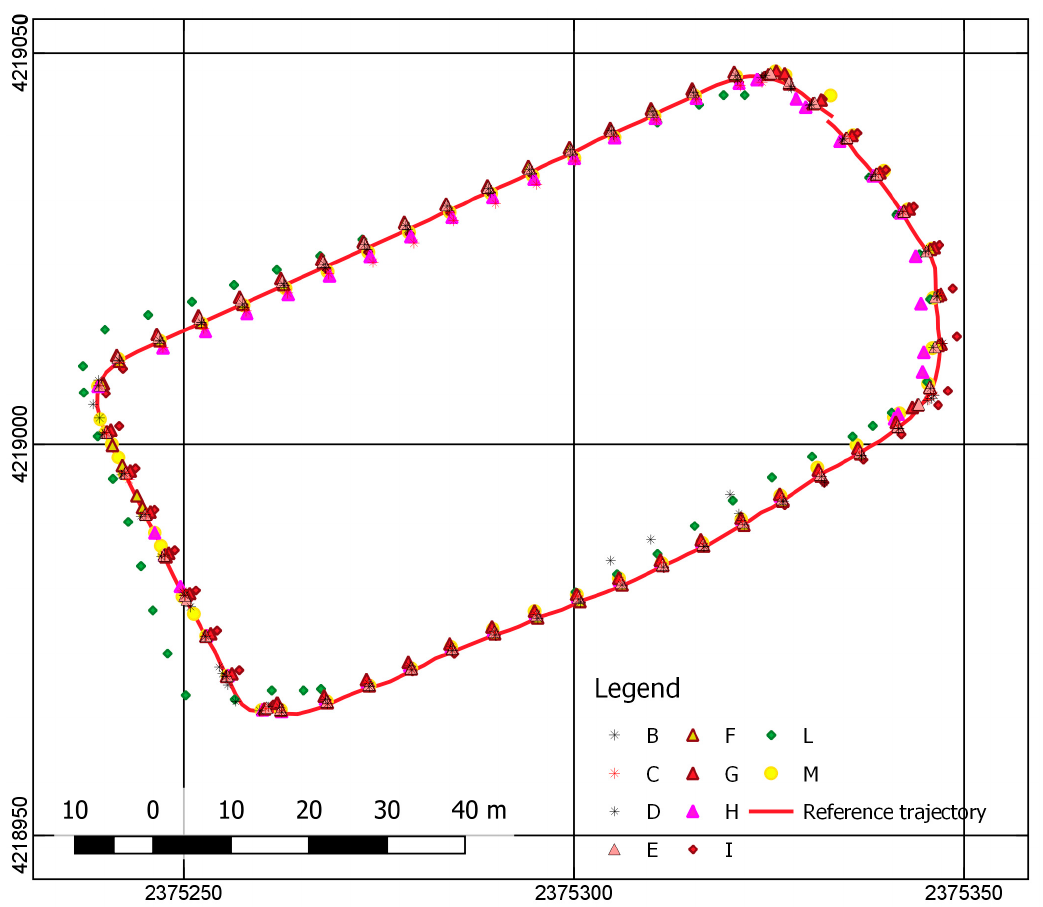
Figure 4. Plot of the trajectories obtained using the four satellite receivers together with the reference one (test A).